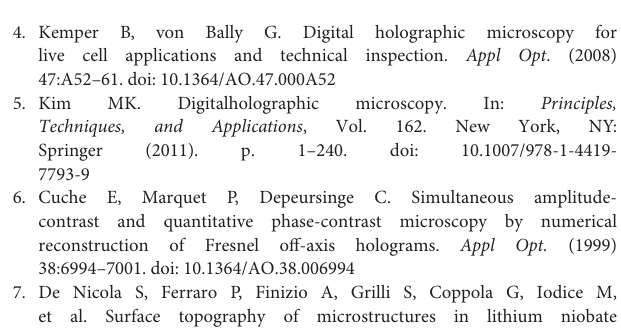
Supplementary Video 2 | Set of retrieved and averaged phase distributions in the scanning of the Ronchi grating. Supplementary Video 3 | Set of thickness distributions computed showing the topography of Ronchi